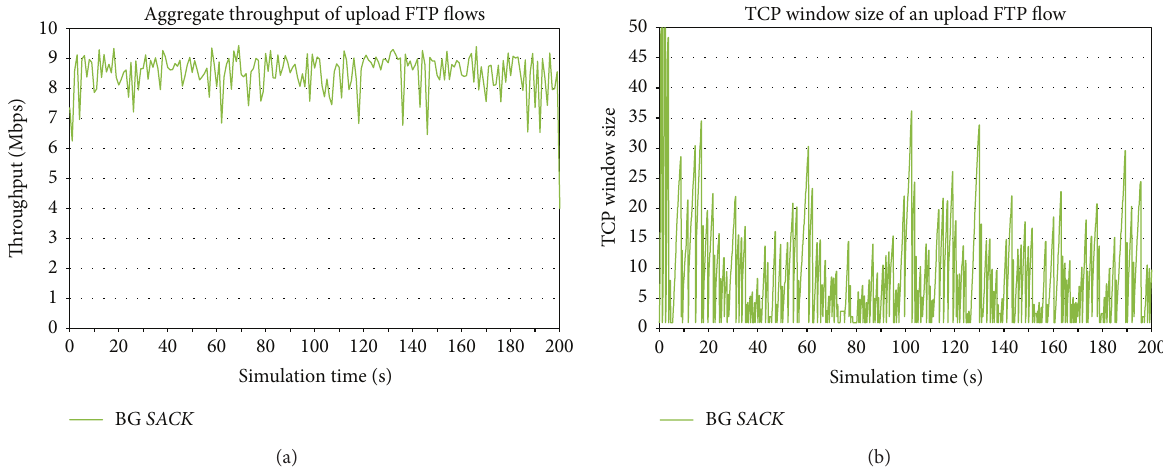
Figure 9: Competition of MMORPG and FTP background traffic using TCP SACK : (a) aggregate throughput of the 10 FTP flows and (b) evolution of the TCP window of one of the